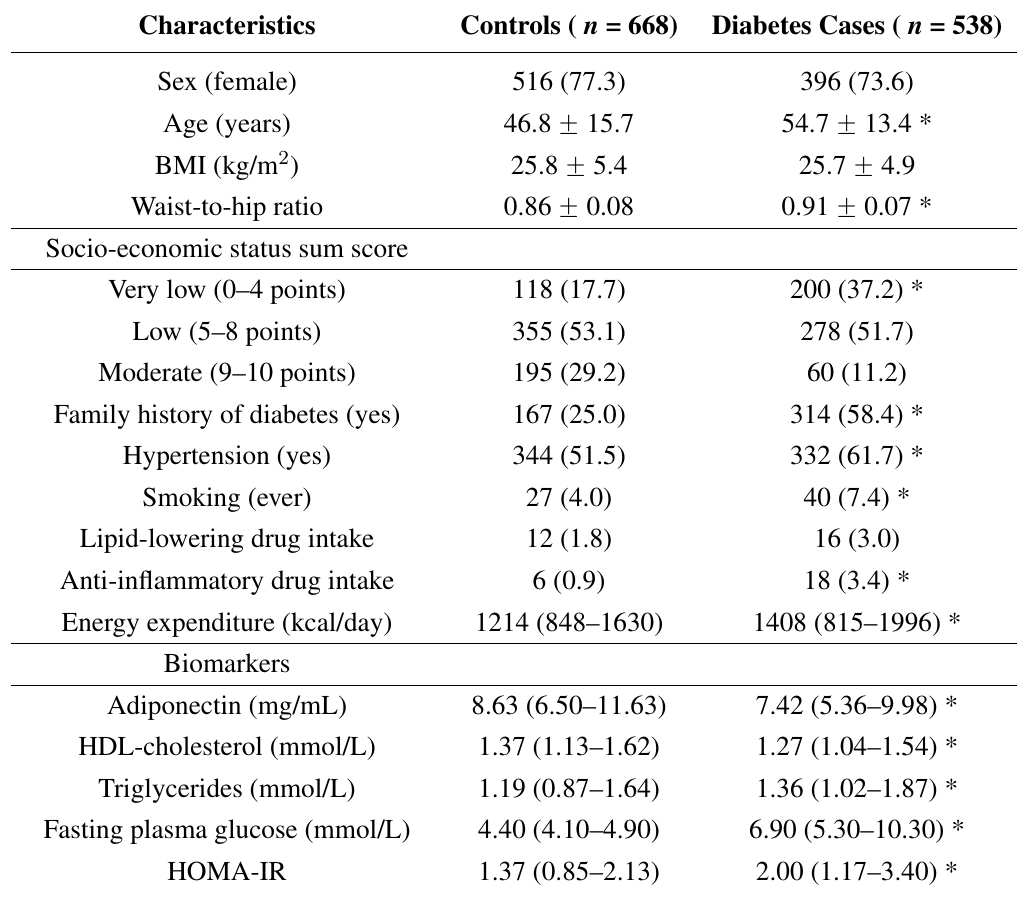
Table 1. Characteristics and biomarkers of 1206 urban Ghanaians of the Kumasi Diabetes and Hypertension